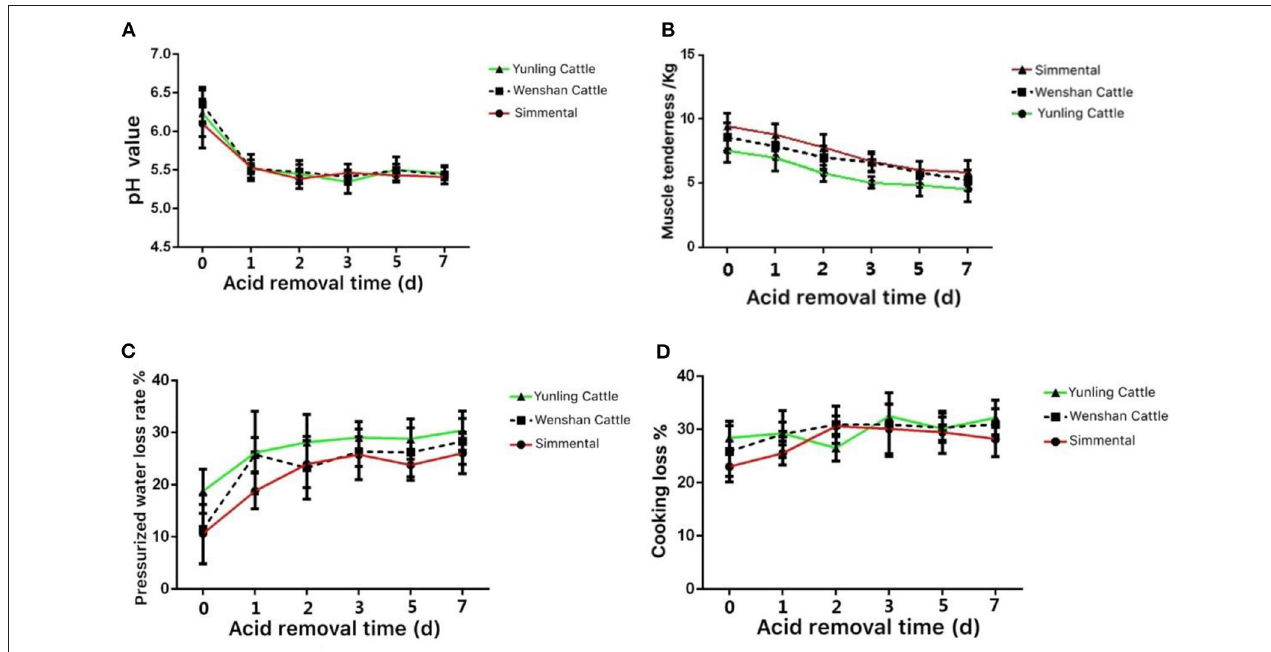
FIGURE 3 | Meat quality of the three cattle breeds. (A) Change in pH value in the muscle aging process of different breeds of cattle; (B) change in muscle tenderness in the muscle aging process of different breeds of cattle; (C) change in pressurized water loss rate in the muscle aging process of different breeds of cattle; (D) change in weight while cooking in the muscle aging process of different breeds of cattle. Data were presented as means ± SD of at least three independent experiments.